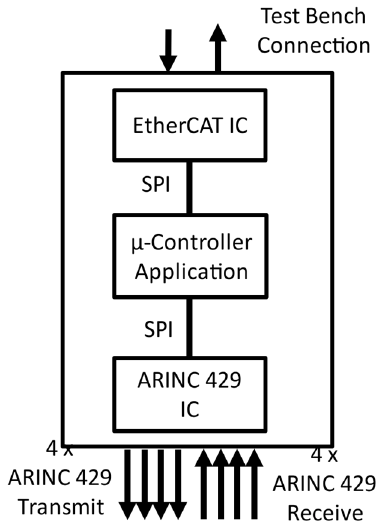
Figure 9. ARINC 429 EtherCAT Slave Components.